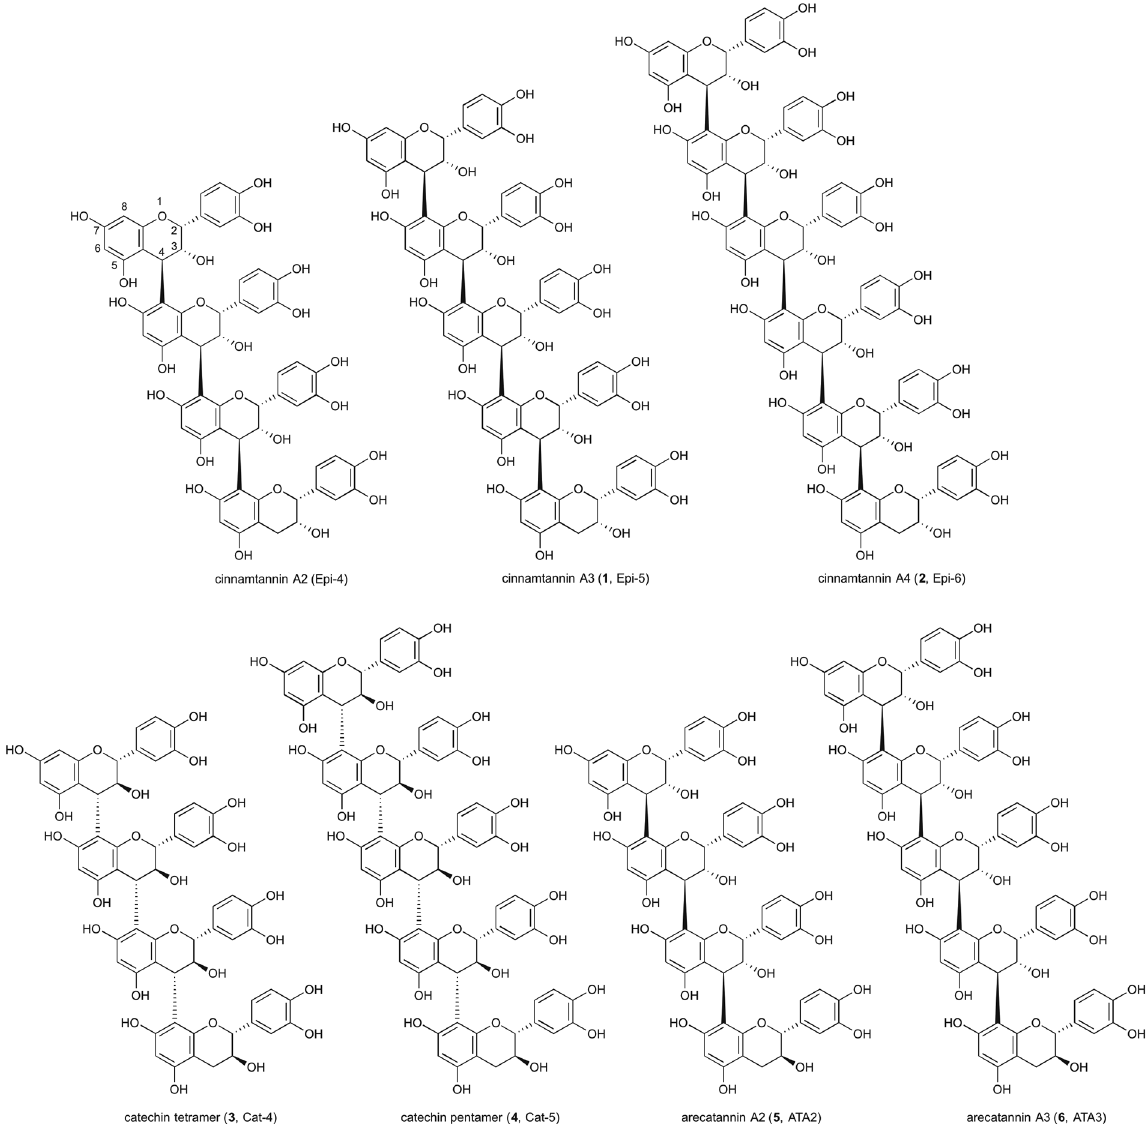
Figure 1. The structures of synthesized catechin and epicatechin oligomers. Syntheses of cinnamtannin A3 (epicatechin pentamer, Epi-5), A4 (epicatechin hexamer, Epi-6), catechin tetramer (Cat-4), pentamer (Cat- 5), arecatannin A2 (epicatechin-epicatechin-epicatechin-catechin, ATA2) and A3 (epicatechin-epicatechin- epicatechin-epicatechin-catechin, ATA3) were